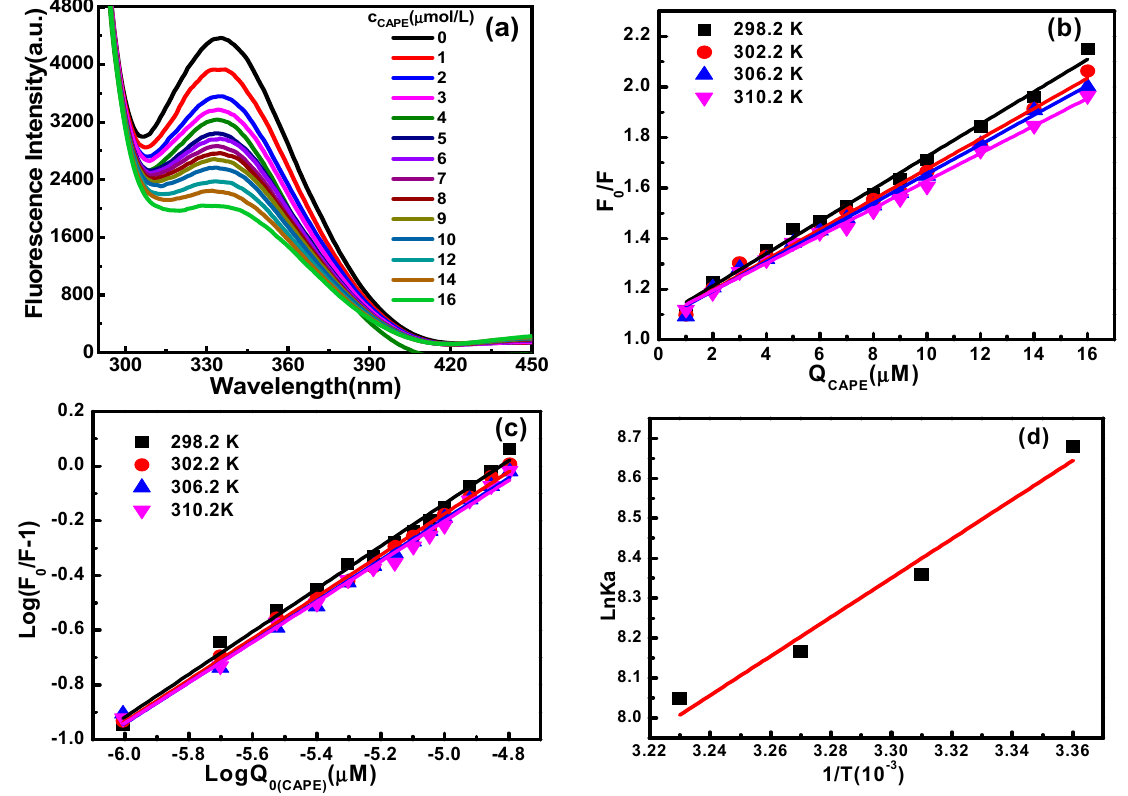
Figure 2. ( a ) Fluorescence spectra at 298.2 K; ( b ) Stern–Volmer plots at di ff erent temperatures; ( c ) The log(( F 0 − F )/ F ) and log[ Q ] 0 double-logarithmic plots at di ff erent temperatures; and ( d ) Van’t Ho ff plots of ln K a versus 1/ T for the CAPE − Hb system in pH 7.4 phosphate bu ff er solution.